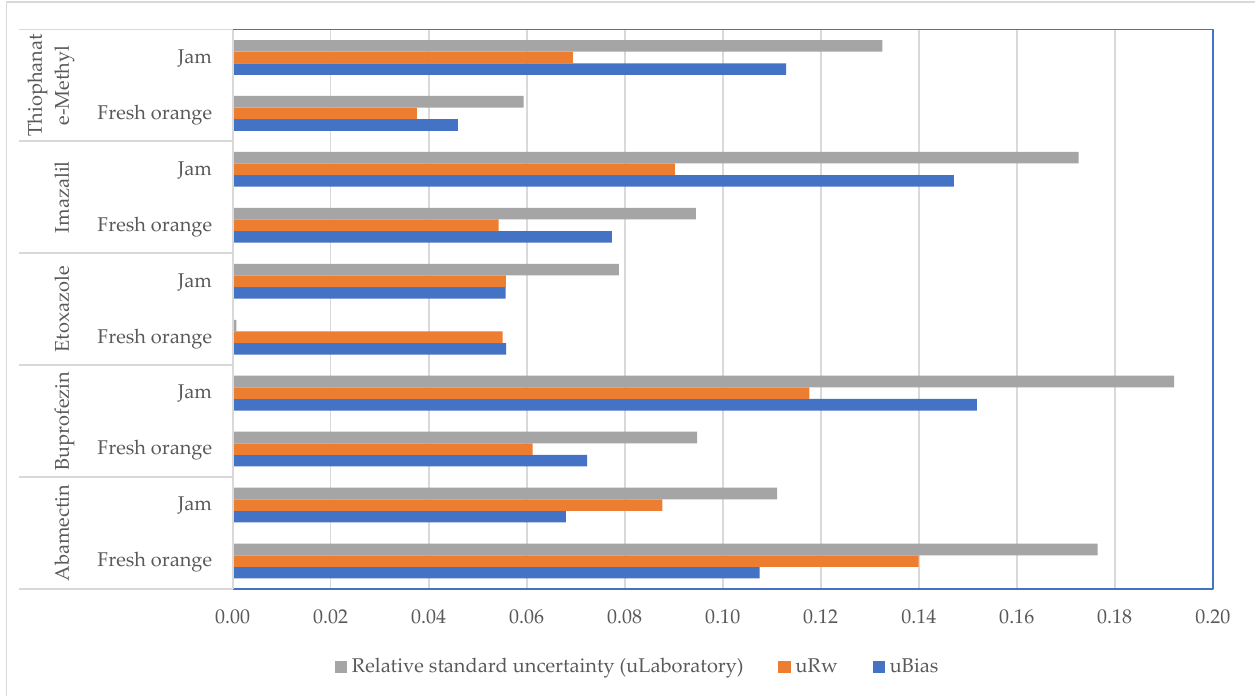
Figure 3. Uncertainty components (SANTE 2021).